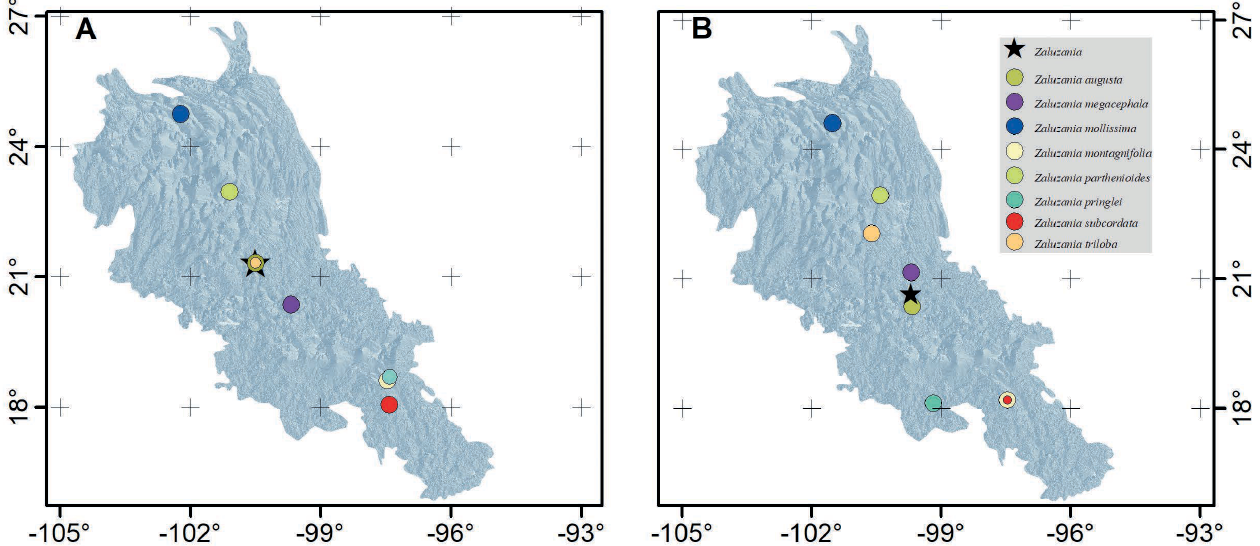
Figure 3 – Environmental and geographic centroids of the genus Zaluzania as a whole (star) and the eight Zaluzania species analysed (circles). A . Environmental centroids. B . Geographic centroids. Maps created using ArcMap 9.3 (https://www.arcgis.com). © Esri and its licensors, all rights reserved. This image is not distributed under the terms of the Creative Commons license of this publication. For permission to reuse, please contact the rights